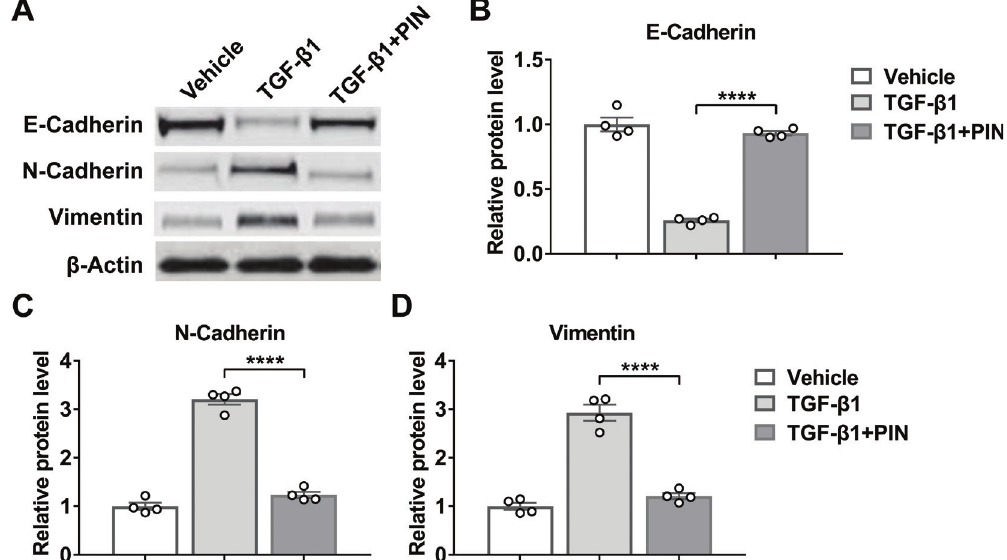
Fig. 3. Pinocembrin inhibited TGF- β 1-induced EMT in A549 cells. A549 cells were treated with 10 ng/ml TGF- β 1 and with or without 50 μM pinocembrin (PIN) for 24 h, and the protein levels of E-Cadherin (A and B), N-Cadherin (A and C), and Vimentin (A and D) were determined by western blot. Four wells per group. The significant difference was analyzed using one-way ANOVA test. **** P <